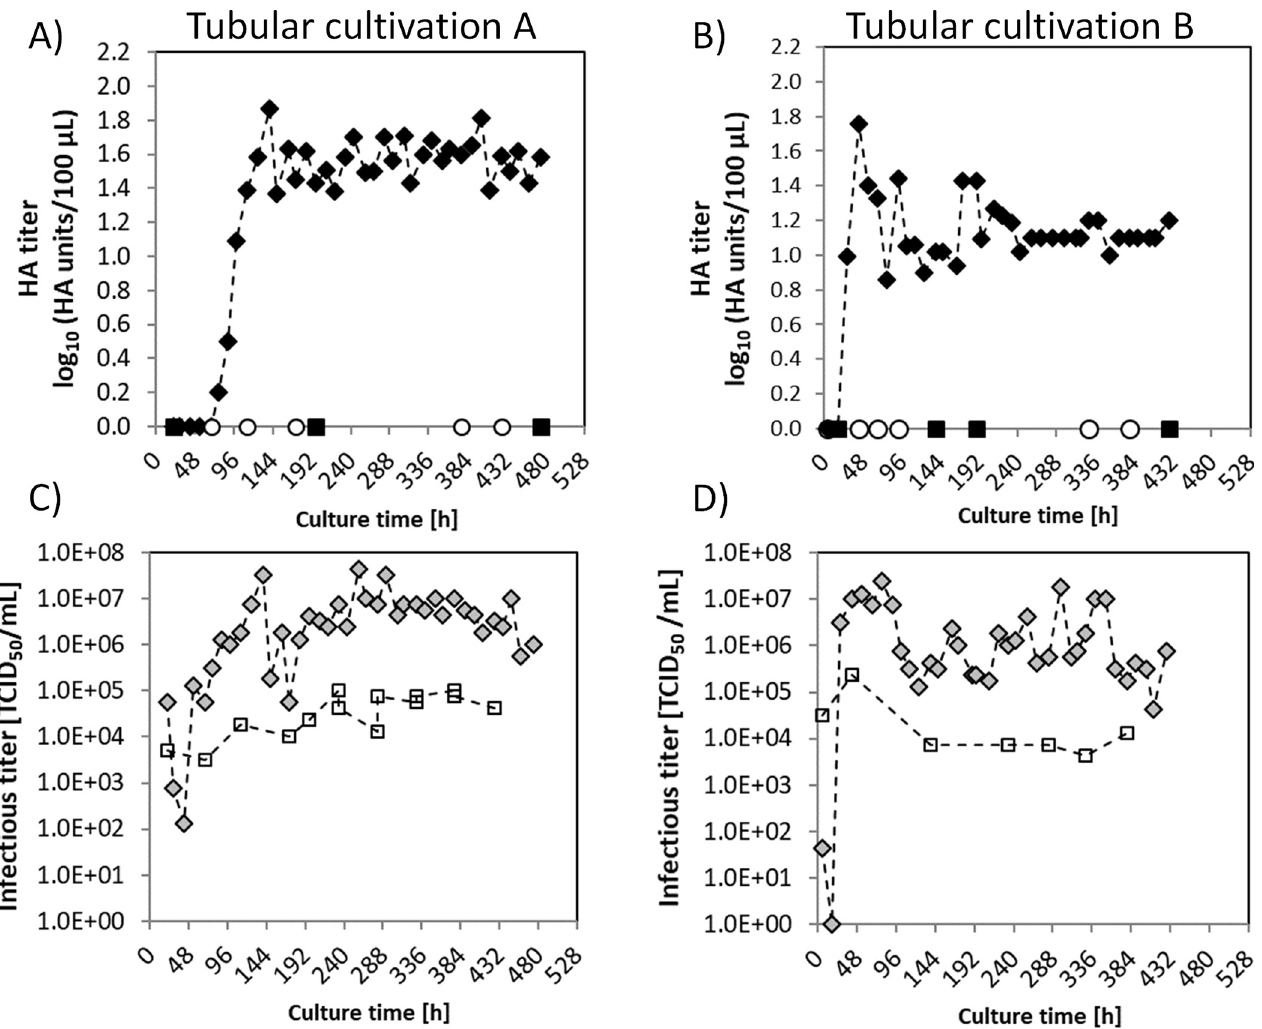
Fig 6. Influenza virus titers in AGE1.CR.pIX cells in the continuous tubular bioreactor system. A) Influenza virus HA titers in the PFBR harvest (closed diamonds), in the VS (open circles) and in the CSTR (closed squares) of tubular cultivation A. B) Influenza HA virus titers in the PFBR harvest, VS and CSTR (same symbols than A) of tubular cultivation B. C) Influenza virus TCID 50 titers of the harvest (diamonds) and of the VS (squares) of tubular cultivation A. D) Influenza TCID 50 titers of the harvest and VS of tubular cultivation B (same symbols than